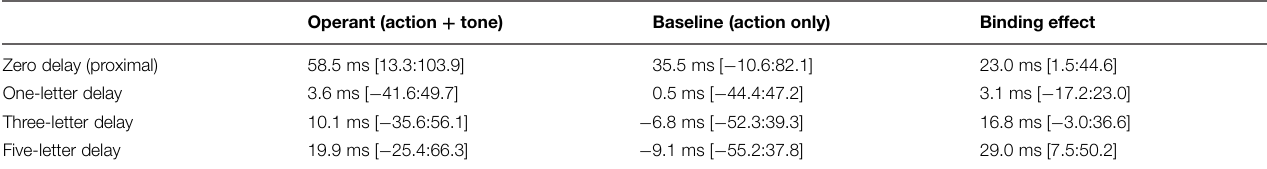
TABLE 2 | Reported occurrence of the press for operant conditions and baseline conditions, and the binding effect indicating the shift from baseline to operant condition, for all subjects. Operant (action + tone) Baseline (action